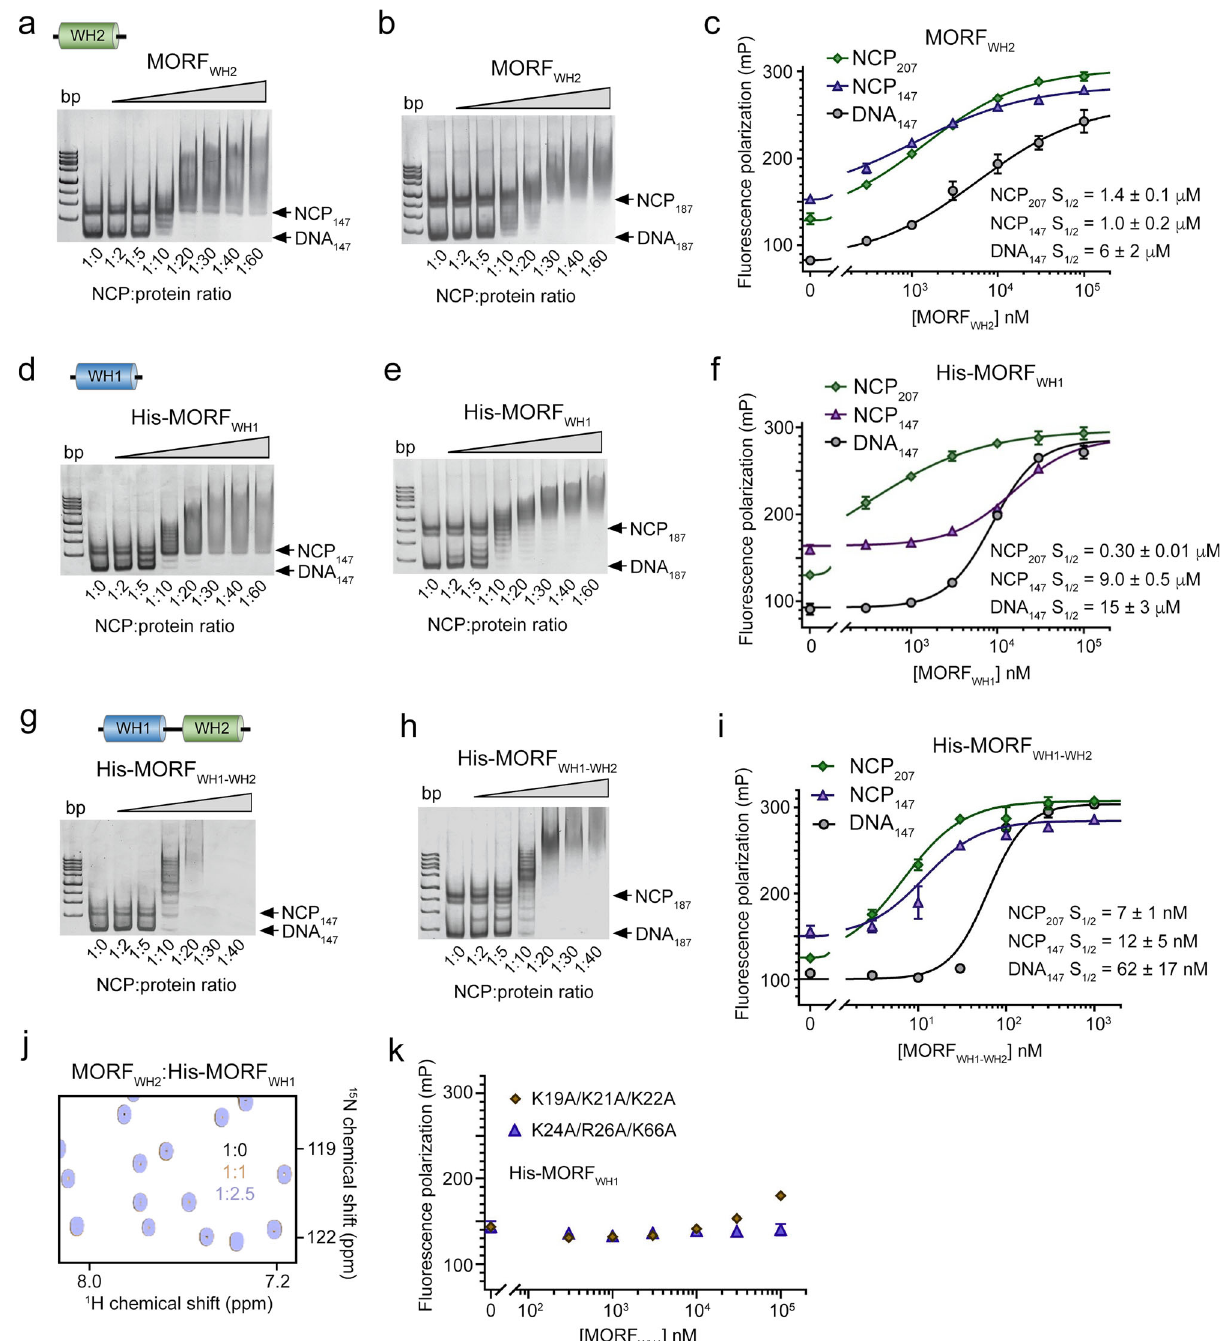
Fig. 7 | Cooperative binding of MORFWH1-WH2 to the nucleosome. a , b EMSAs of 147bp NCP (NCP 147 ) and 187bp NCP (NCP 187 ) in the presence of increasing amounts of MORF WH2 . NCP:protein ratio is shown below the gel images. c Binding curves for the interactions of MORF WH2 with NCP 207 , NCP 147 , and DNA 147 as mea- suredby fl uorescencepolarization.Datarepresentmean±SDofthreeindependent experiments. n =3. d , e EMSAs of NCP 147 and NCP 187 in the presence of increasing amounts of His-MORF WH1 . NCP:protein ratio is shown below the gel images. f BindingcurvesfortheinteractionsofMORF WH1 withNCP 207 ,NCP 147 andDNA 147 as measured by fl uorescence polarization. Data represent mean±SD of three inde- pendent experiments. n =3. g , h EMSAs of NCP 147 and NCP 187 in the presence of